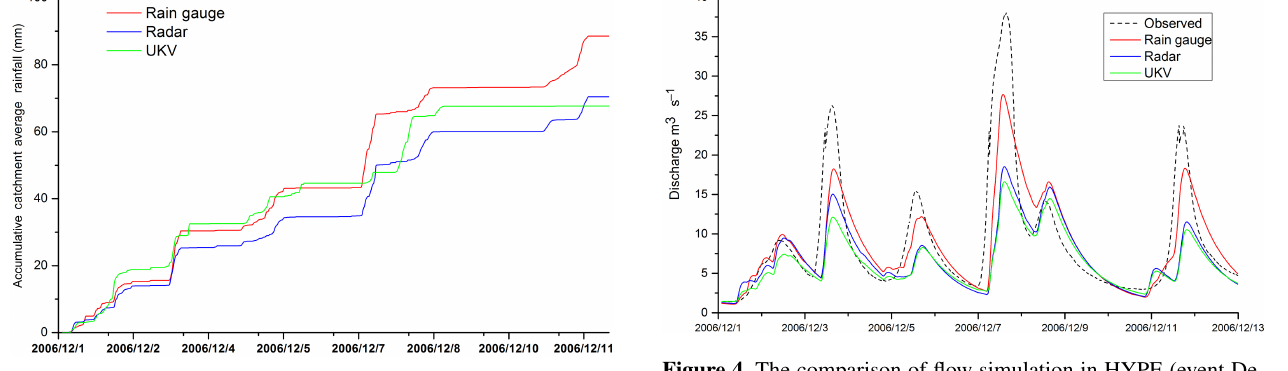
Figure 3. The comparison of accumulative catchment average rain- fall (event December 2006).